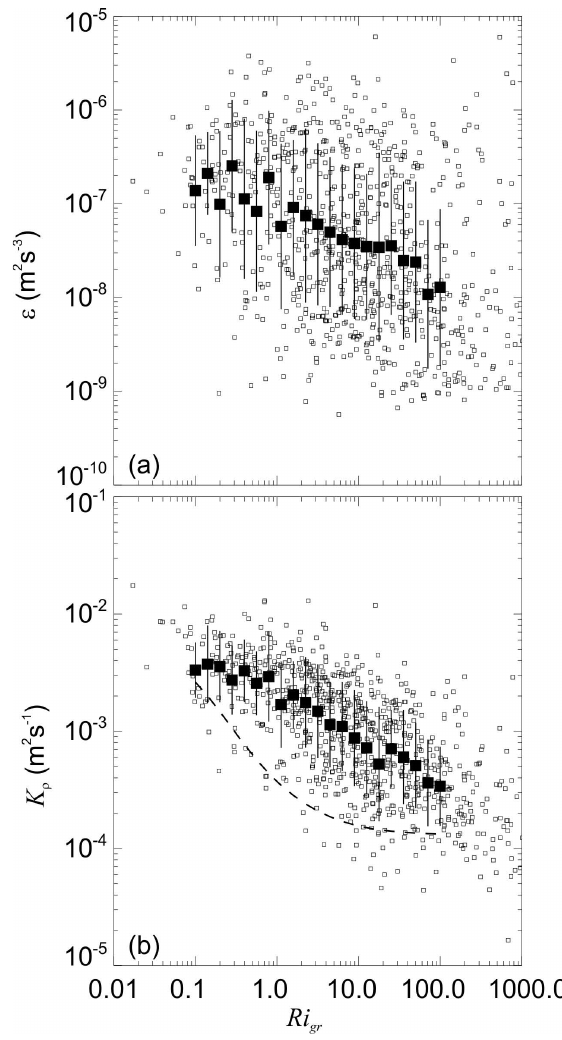
Fig. 11. (a) Dissipation rate as a function of Rigr showing in- dividual estimates (hollow squares), bin-log-space-averaged (solid squares) and bars showing standard deviation of estimates for 0.15 log ( Ri gr ) spaced bins. (b) The Shih et al. (2005) estimate of diffu- sivity K ρ and the Fer (2006) parameterization of vertical diffusivity of mass (dashed